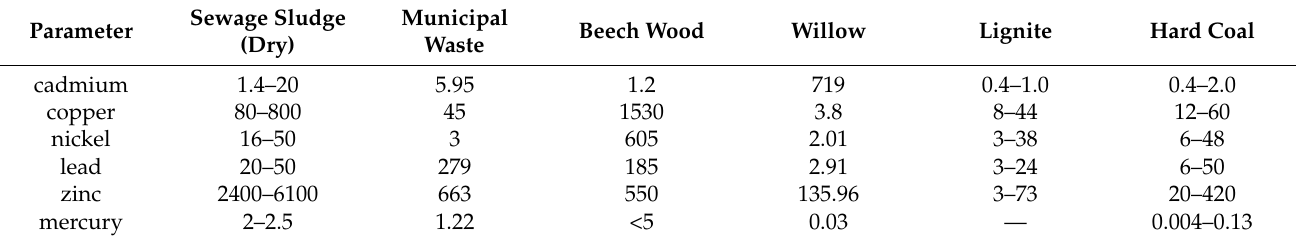
Table 1. The share of heavy metals in fuels, in mg/kg